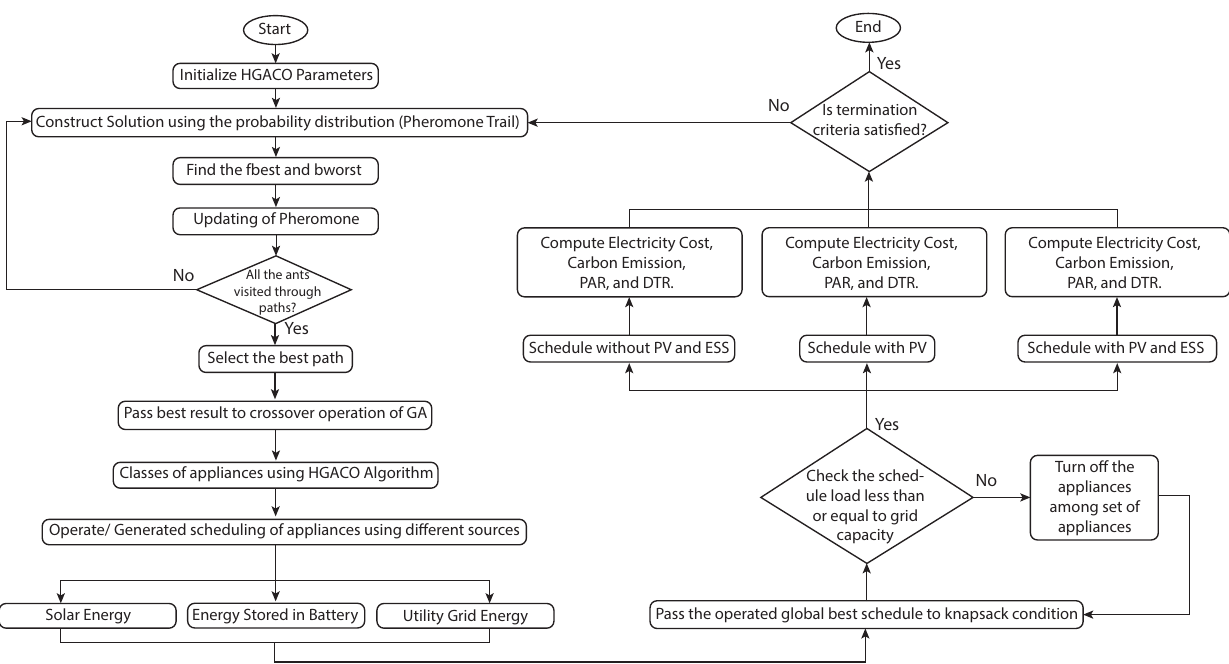
Figure 3. Complete implementation flowchart of the proposed system